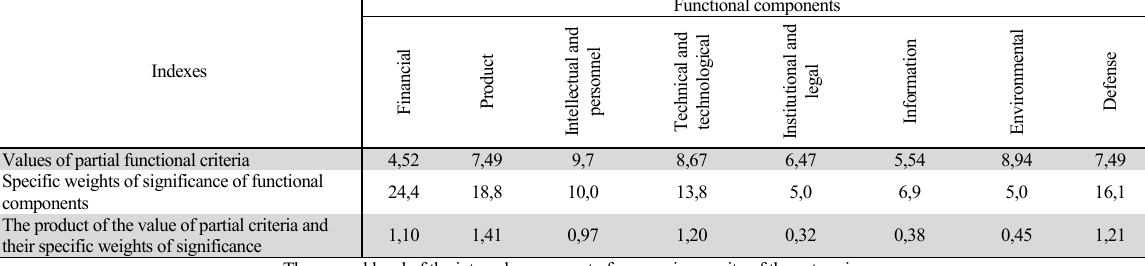
Calculation of the general level of economic security of the MCEOE